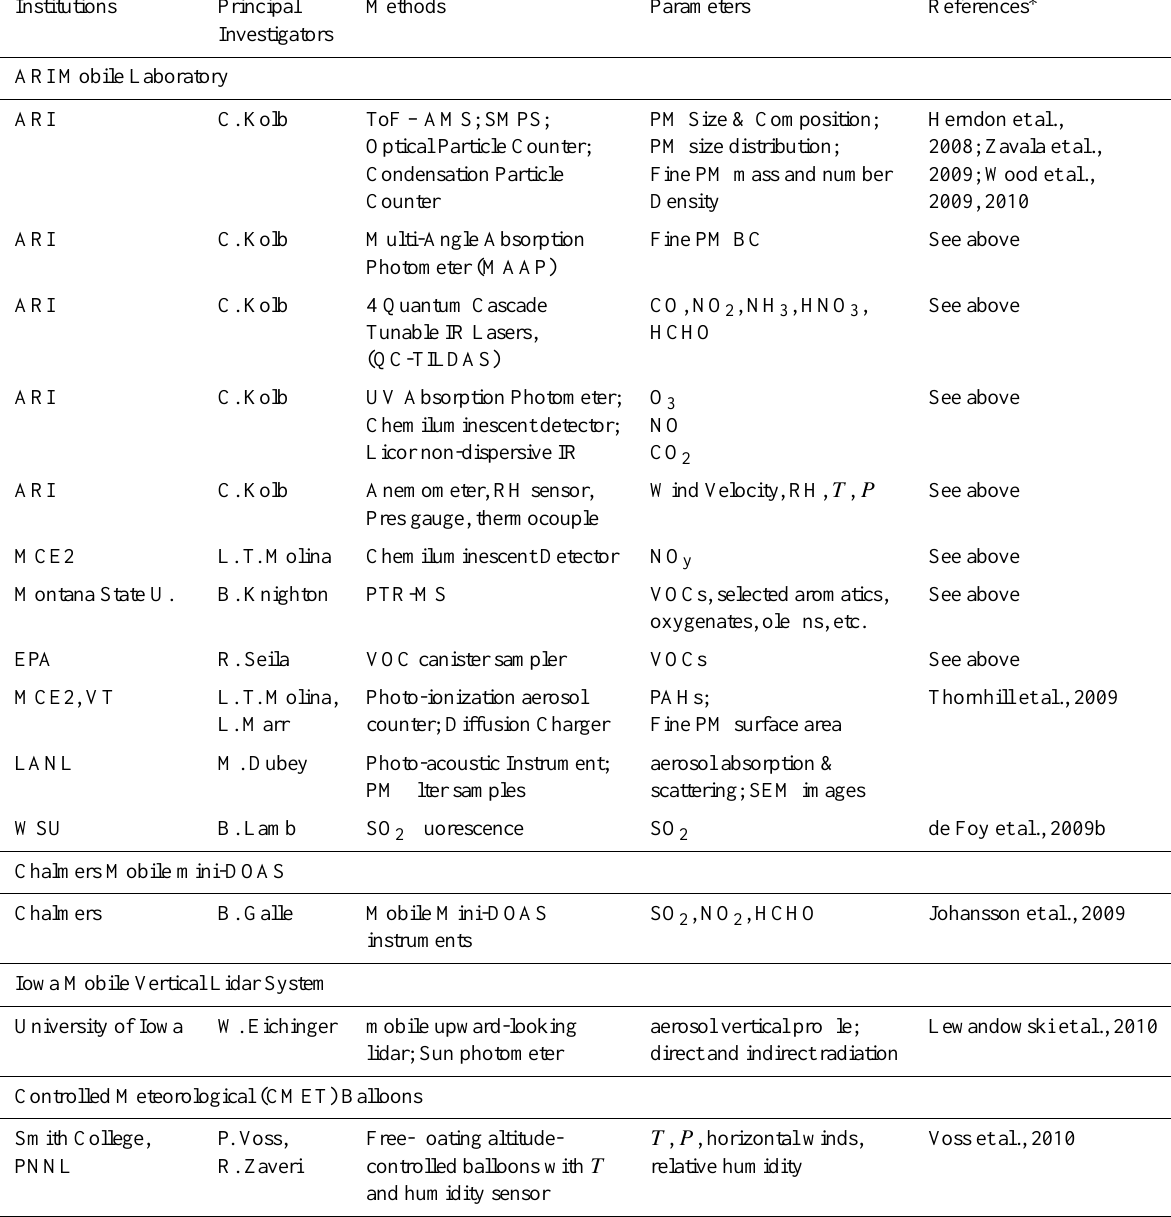
Table 4. List of participating institutions and instruments deployed in the mobile labs and mobile